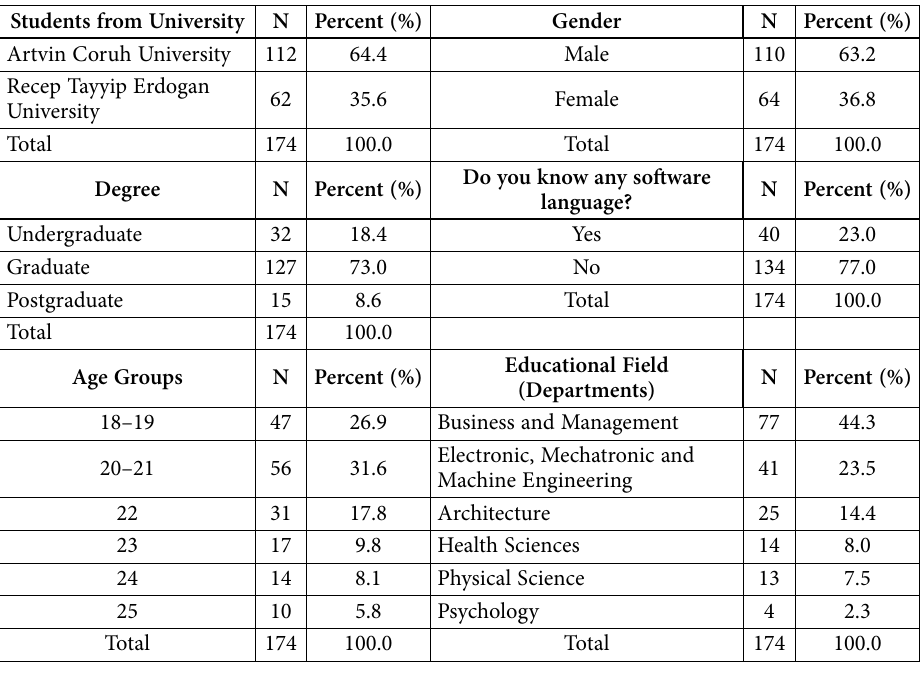
Table 4. Demographic characteristics of the participants